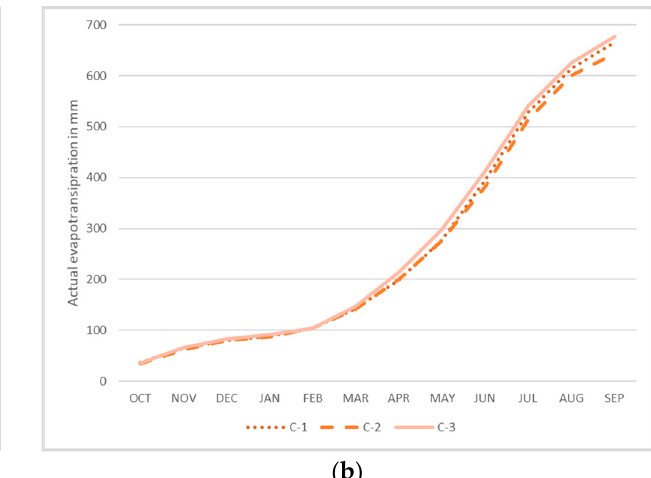
Figure 7. Annual average precipitation and snowmelt (in mm) for the three configuration periods.